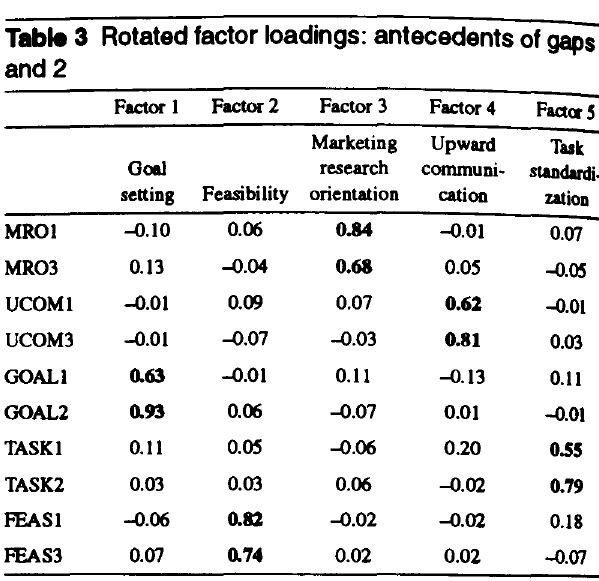
Table 3 Rotated factor loadings: antecedents of gaps 1